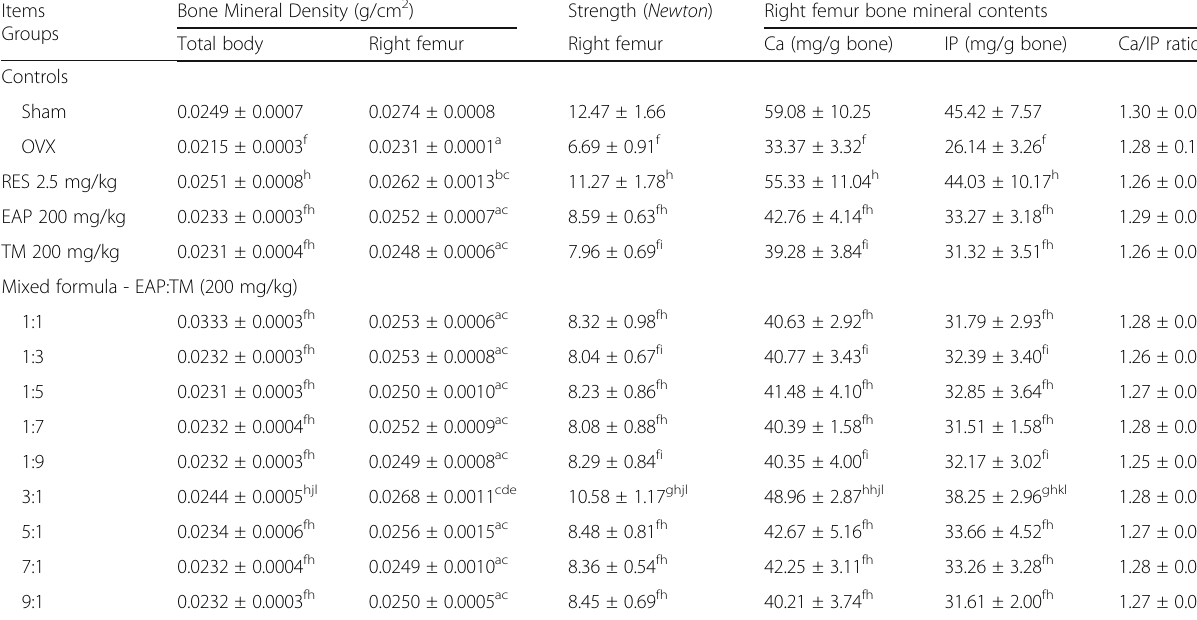
Table 3 Bone femur strength, and mineral content (Ca and IP) in sham-operated and OVX mice Items Bone Mineral Density (g/cm 2 Groups